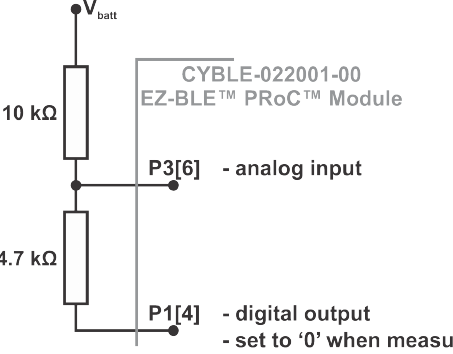
Figure 3. Battery level measurement